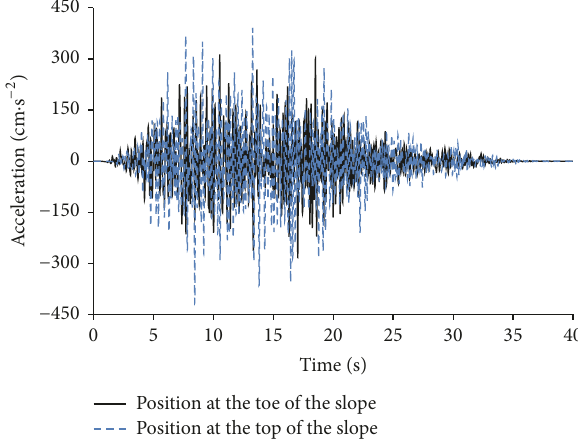
Figure 8: The distribution of the amplification coefficient applying different method.